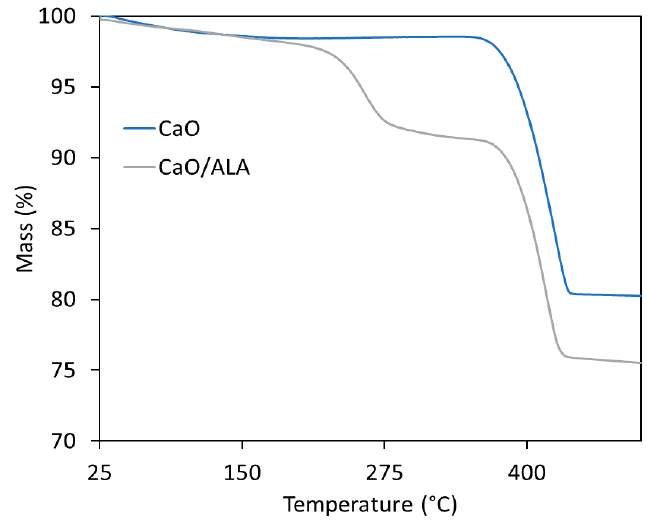
Figure 1. Thermogravimetric (TG) curves for pure and ALA-modified CaO.